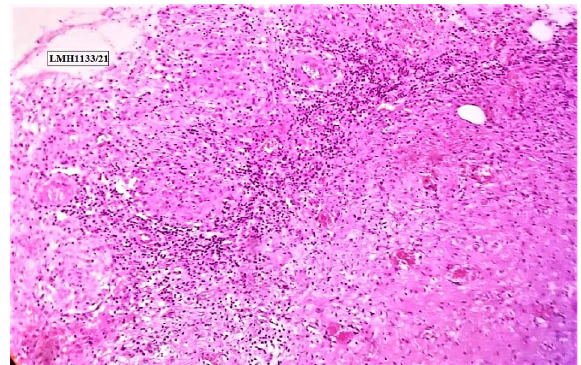
Figure 9. Hand E-stained slide [ (cid:1) 100 magni fi cation] showing multinucleated giant cells and granulation tissue.